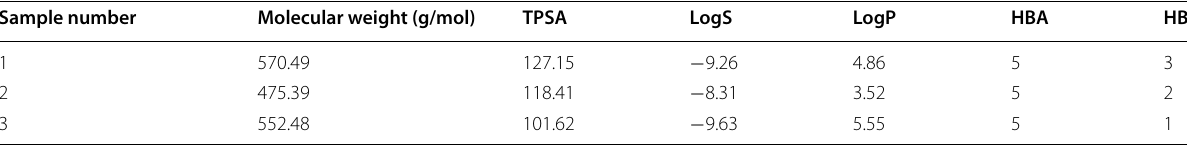
Table 4 Drug-like properties of the quinazolines 1–3 Sample